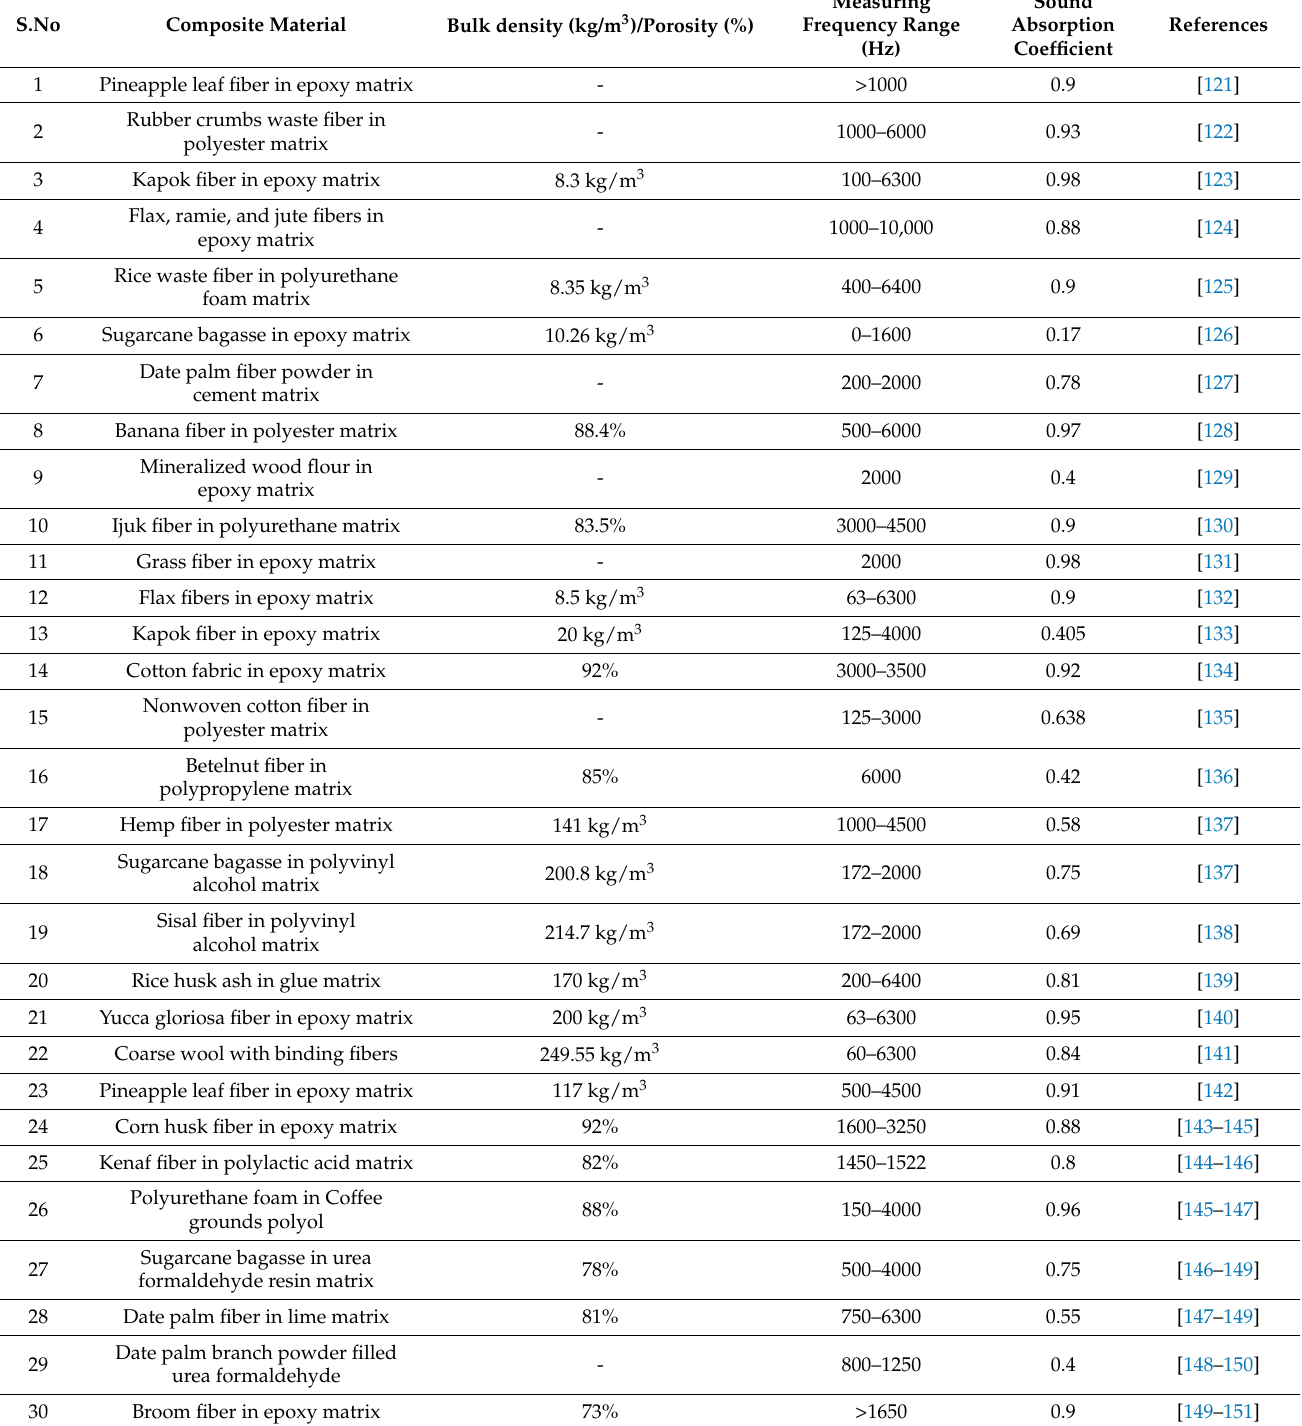
Table 2. Acoustic properties of natural fiber polymer